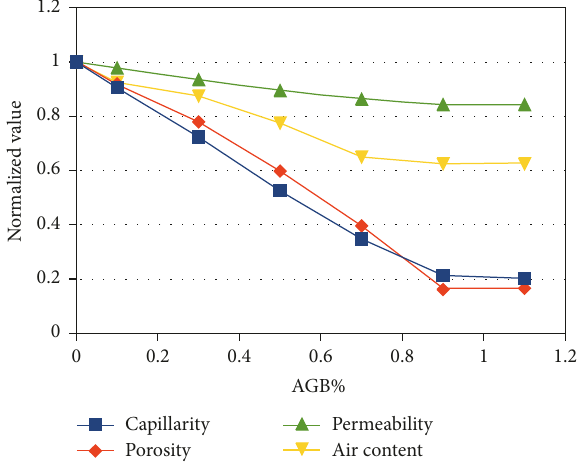
Figure 5: Flexural and tensile strength of concrete variation with AGB%.